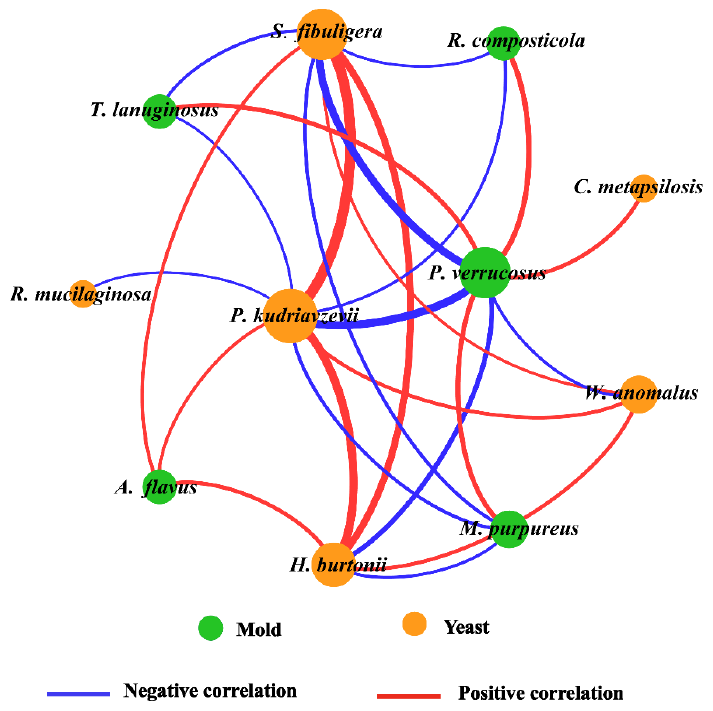
Figure 12. Network analysis of the key fungi in